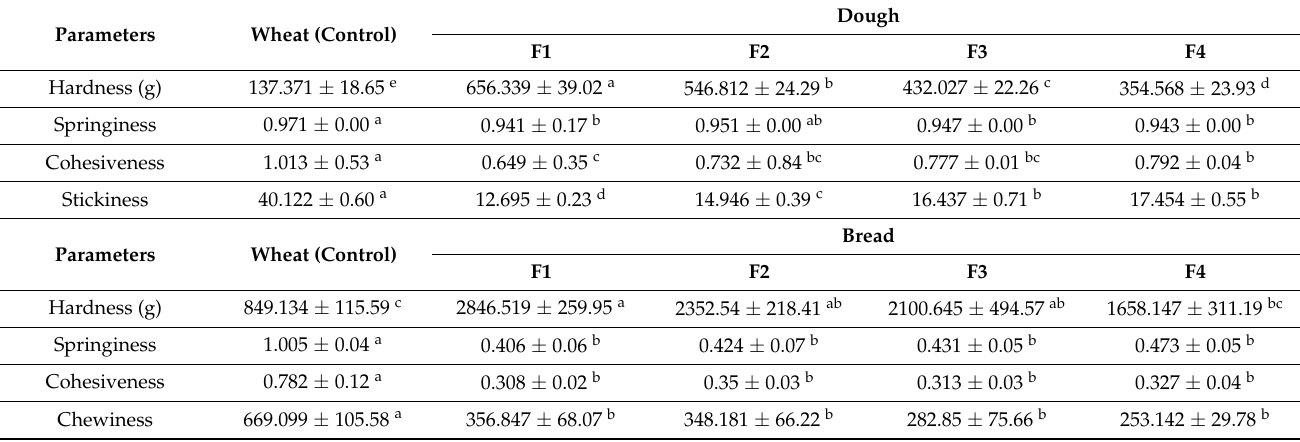
Table 5. TPA results for gluten-free rice dough and